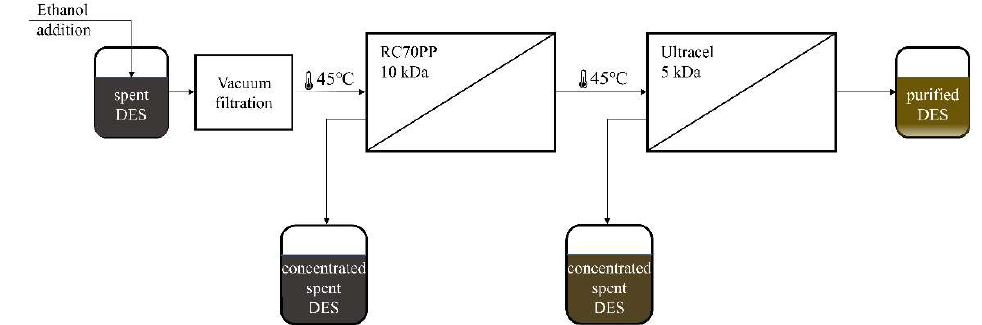
Figure 1. Spent DES purification process with multistage ultrafiltration.